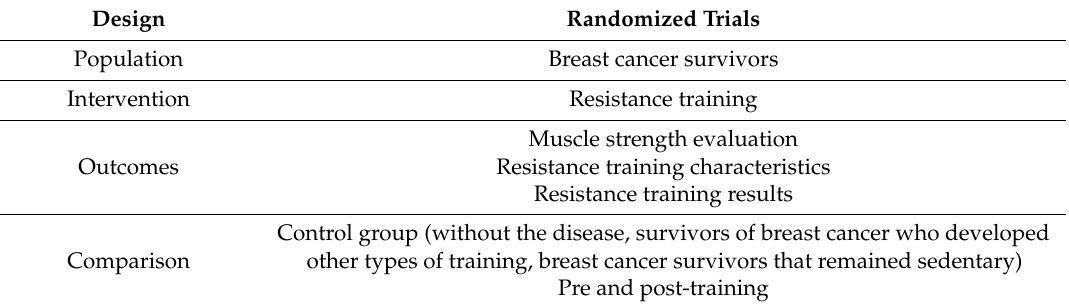
Table 3. Inclusion